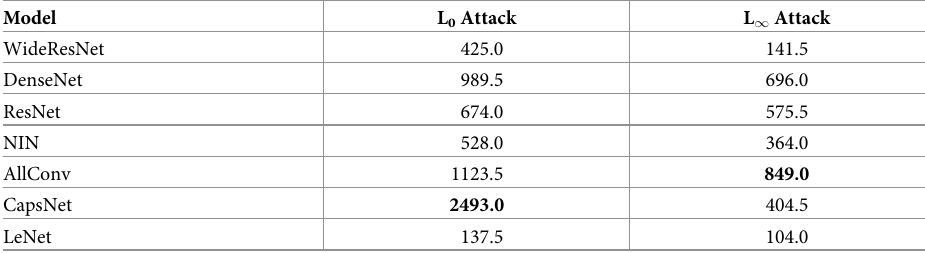
Table 6. Area under the curve (AUC) for both Few-Pixel ( L 0 ) and Threshold ( L 1 ) black-box attacks.